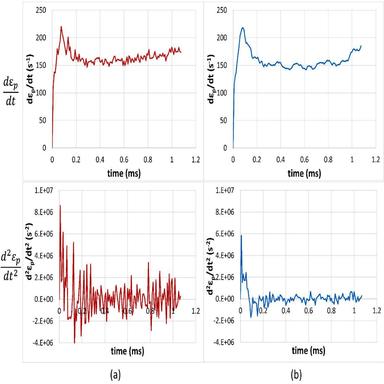
Comparison of the results (a) before applying temporal smoothing (b) after applying temporal smoothing.